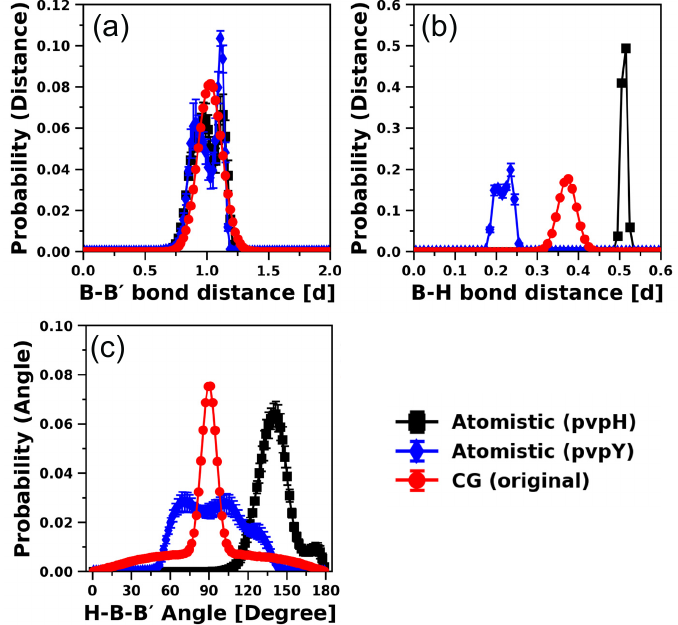
Figure 2. Comparison of probability distributions of ( a ) B–B´ distance, ( b ) B-H distance, and ( c ) H–B– B´ angle for 24-mer pvpH and pvpY chains, obtained from atomistic simulations of 24-mer pvpH and pvpY chains and CG 24-mer chain simulations using the generic CG model of Kulshreshtha et al. [109] (denoted as “original” CG model). The standard deviations are computed from the means of 5 independent trials for atomistic simulations and 10 independent trials for CG simulations and the lines joining the symbols are drawn to guide the eye.